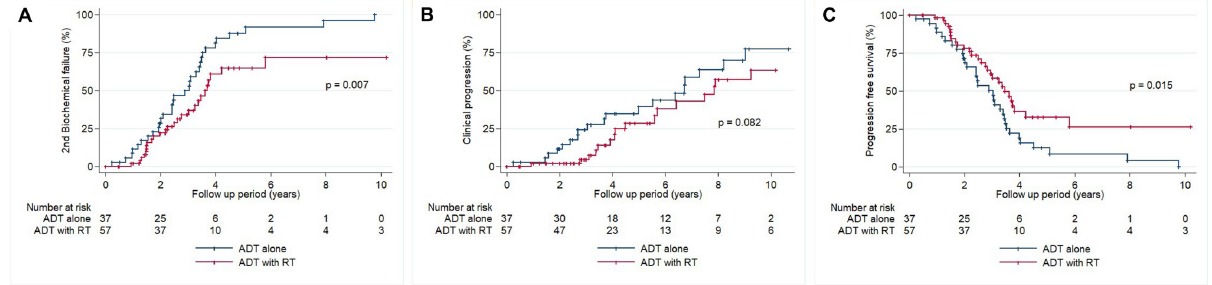
Fig 2. Actuarial treatment outcome curves of patients who received salvage ADT alone vs. ADT with RT. (A) Actuarial curves for 2 nd biochemical failure in the two groups according to salvage treatment method. (B) Actuarial curves for clinical progression in the two groups according to salvage treatment method. (C) Actuarial curves for progression-free survival according to salvage treatment method. Abbreviations: ADT, androgen deprivation therapy; RT,